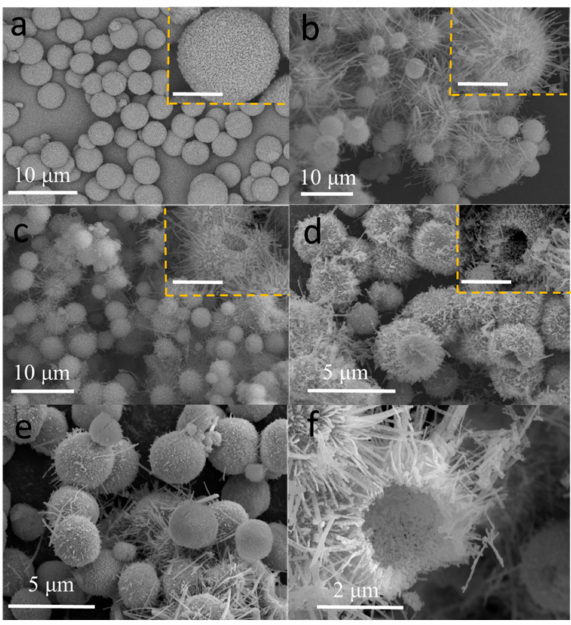
Figure 5. SEM images of as-obtained samples: ( a ) S-CuO; ( b ) H-CuO; ( c ) H-SnO 2 (0.05)-CuO; ( d ) H-SnO 2 (0.1)-CuO; and ( e , f ) H-SnO 2